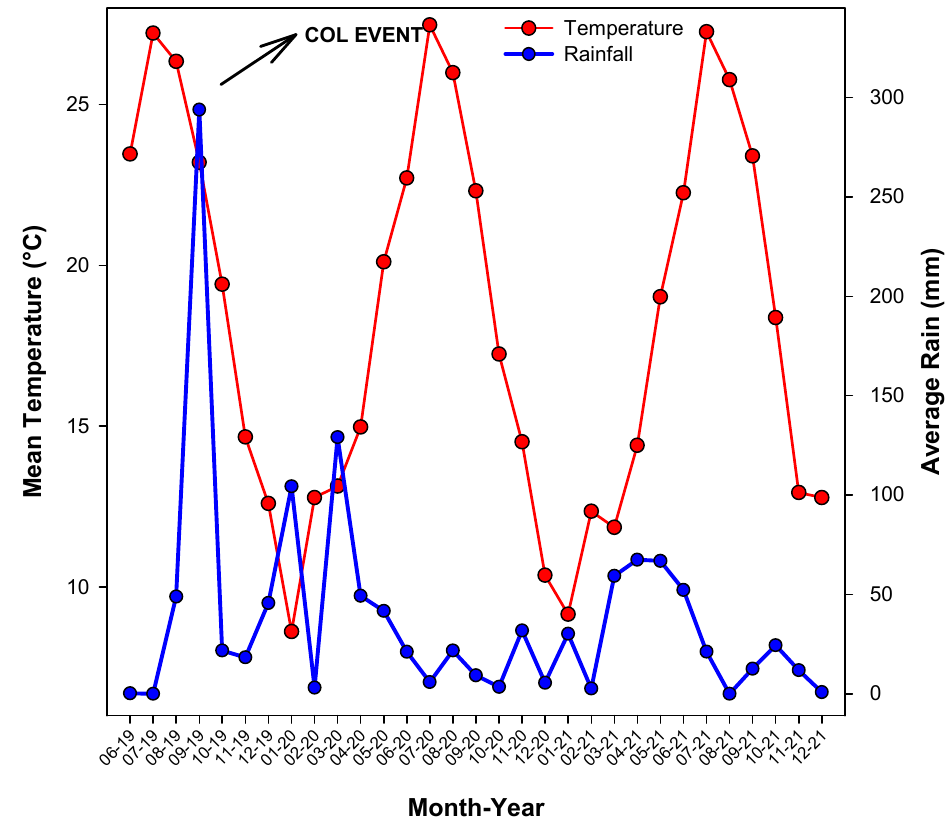
Figure 1. Mean temperature (°C) and rainfall (mm) along the experimental period (2019 and 2020). Treatments were performed by foliar spray application with freshly prepared solution (5-L per tree) containing 0.5% Tween 20 as the surfactant and the phenological stage (BBCH- scale) was stage 71. The sprays were carried out with a 15-L backpack sprayer until runoff. Each treatment was repeated three times, starting after the typical fruitlet drop, at the onset of color change, and four days before